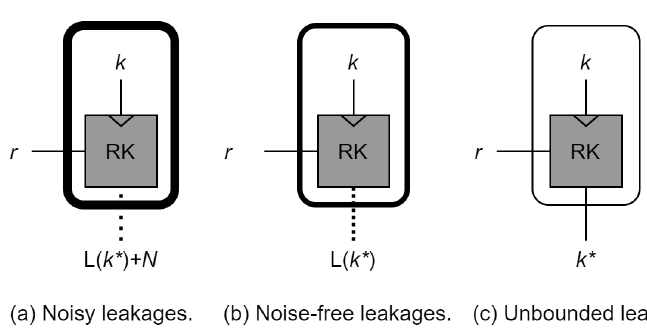
Figure 2: Fresh re-keying adversarial models (from weaker to